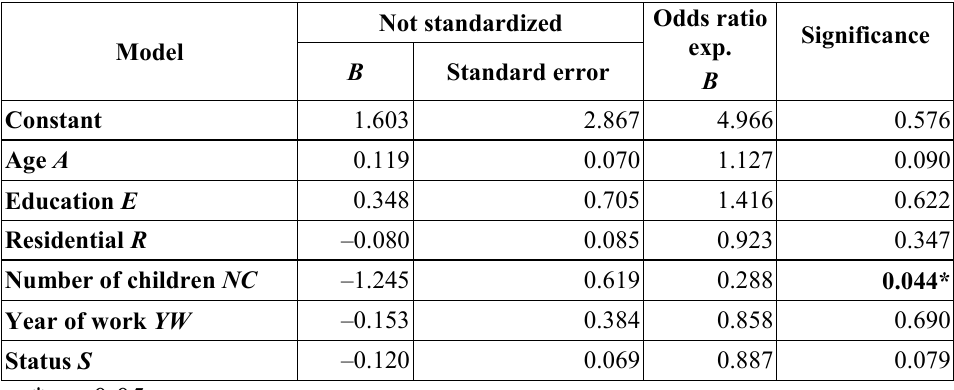
Table 7. Logistics Regression Analysis for Employee Performance Not standardized Model